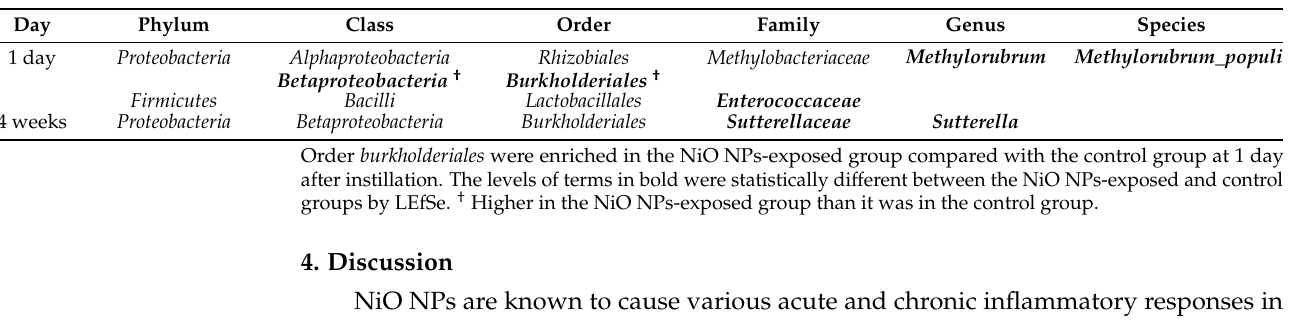
Table 1. Identification of significant differences in bacterial distribution between the nickel oxide nanoparticles (NiO NPs)-exposed (low- and high-dose groups) and control groups based on linear discriminant analysis effect size (LEfSe) analysis.